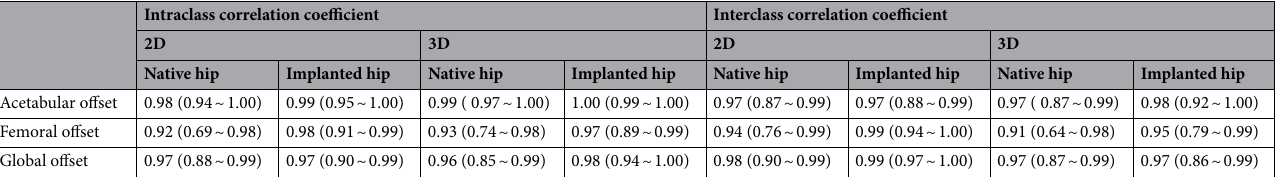
Table 1. Intra-class and inter-class correlation coefficients.